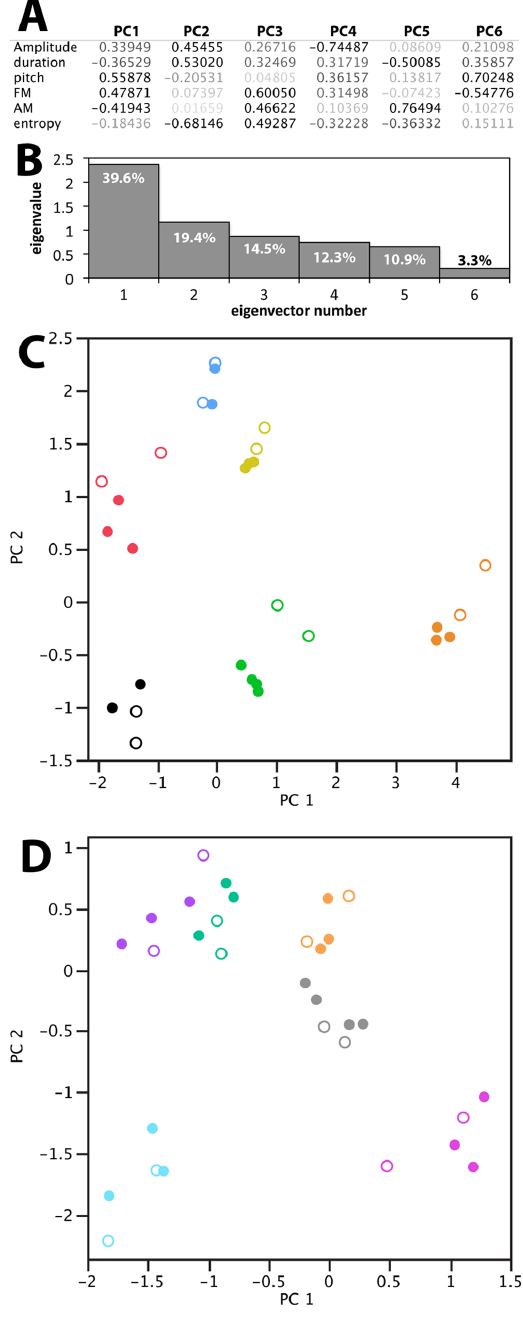
Fig. 5. Principal Component Analysis (PCA) of the effects of alcohol drinking on acoustic parameters of whole song motifs. A. Relative contributions of different acoustic parameters to PCA eigenvectors; the darkness of the print indicates the strength of contribution. B. Scree plot indicating the percent contribution by each eigenvector to the total variation along the axis. Plots of PC2 vs. PC1 for (C) the Alcohol treatment and (D) the Control treatment: unique colors denote individual birds; open and solid circles indicate daily values recorded in Phase II (no alcohol) and Phase III (alcohol) respectively; some individual values are not visible as they